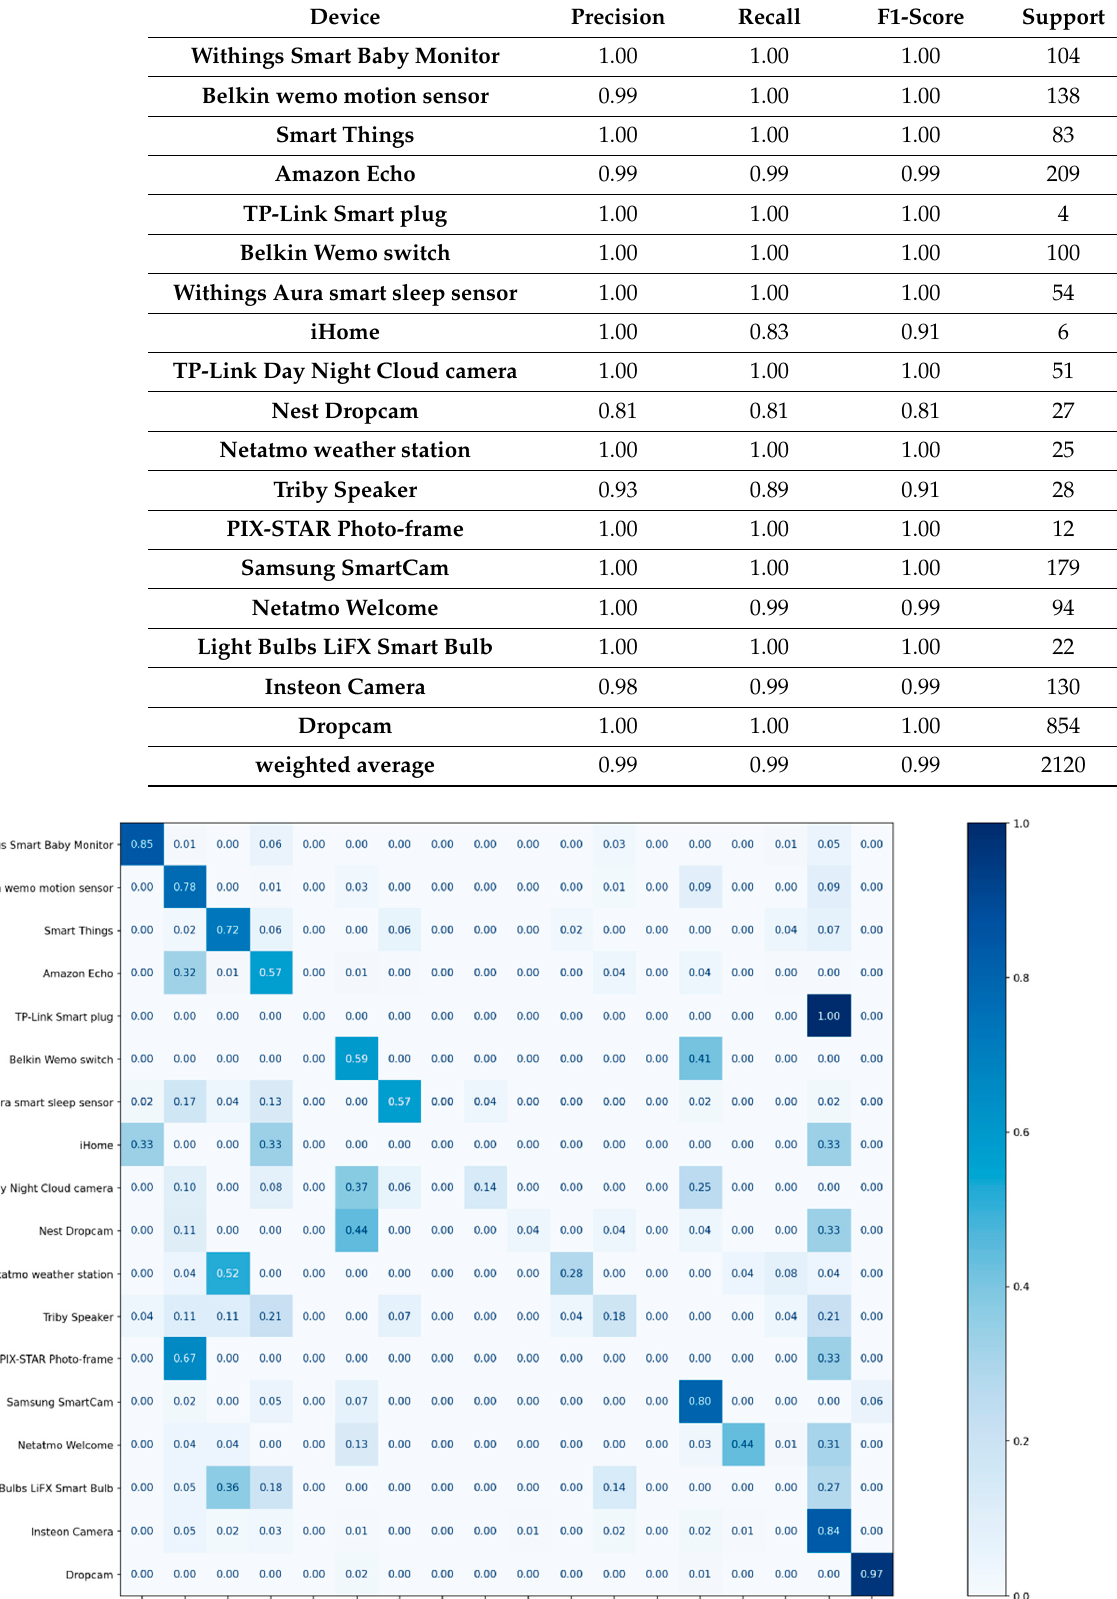
Table 10. The precision, recall, and f1-score results and the numbers of test data for the CNN. Device